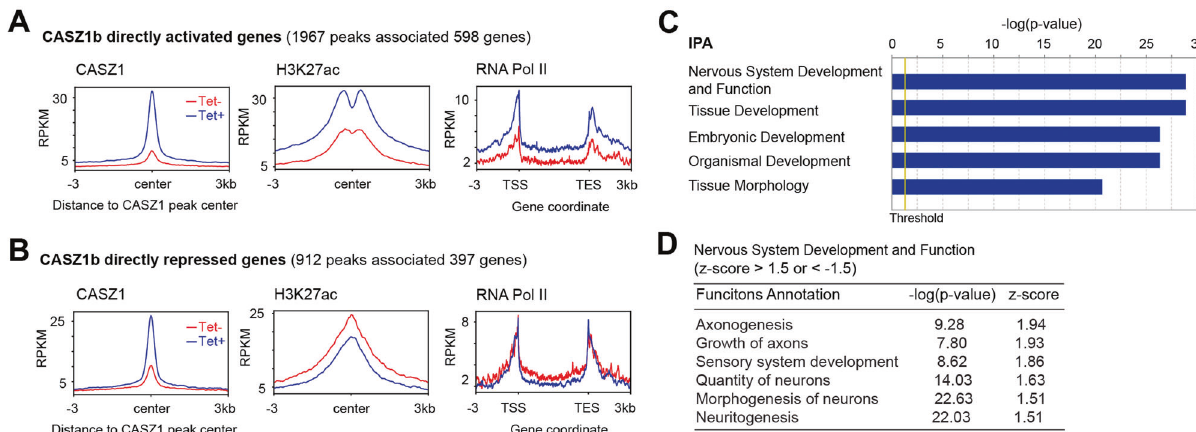
Fig. 5 CASZ1b directly activates neuronal differentiation genes. A Composite plots of the 598 upregulated genes before (Tet-) after (Tet + ) induction of CASZ1b in SY5Y cells, which show increased CASZ1b signals (left panel) and H3K27ac signals (middle panel) at the CASZ1b peak center, as well as increased signals of RNA Pol II on the gene body (right panel). B Composite plots of the 397 genes directly downregulated by CASZ1, which show increased CASZ1b signals (left panel) and decreased signals of H3K27ac (middle panel) at the CASZ1b peak center, as well as decreased signals of RNA Pol II on the gene body (right panel). C Ingenuity pathway analysis (IPA) shows that CASZ1b directly regulated genes are involved in nervous system and tissue development. D IPA shows that CASZ1b directly regulated genes are enriched in the positive regulation of neuronal differentiation and